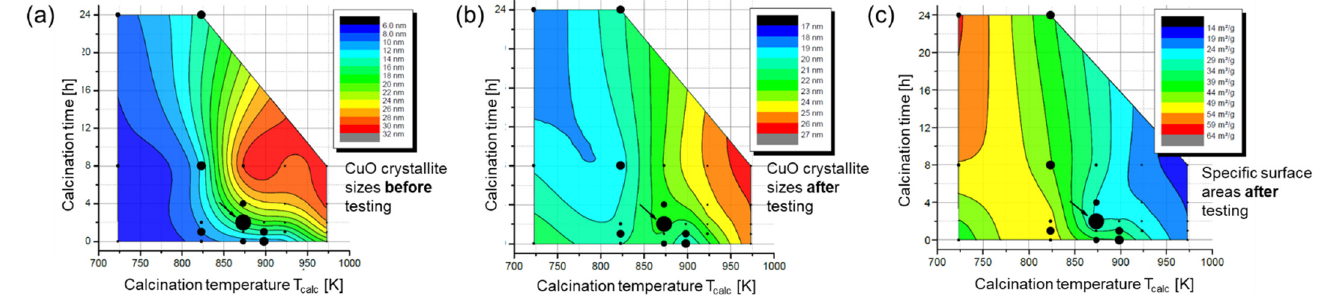
Figure 15. Contour plots of the ( a ) calculated CuO crystallite sizes before and ( b ) after the catalytic testing as well as ( c ) the specific surface area after catalytic testing depending on the calcination temperature and time. The normalized MeOH STYs are depicted as black circles. Normalization was carried out with respect to the highest MeOH STY reached (demonstrated by the black arrow) using a calcination temperature of 873 K and a holding time of 2 h. Catalyst system: Cu 0.61 Zn 0.21 Al 0.18 , h equ. = 600. Catalytic tests: p = 5 MPa, GHSV = 24,000 h − 1 , T react = 503 K, S = 2, Feed = 22 vol% H 2 , 62 vol% CO, 6 vol% CO 2 , 10 vol% Ar.